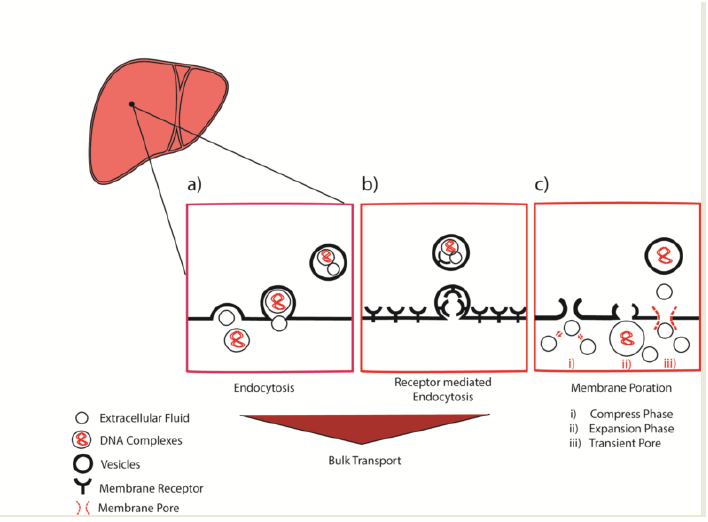
Figure 6. Schematic diagram representing ( a ) Endocytosis ( b ) Receptor mediated endocytosis as the bulk intercellular vesicle transport or ( c ) Membrane poration across the hepatocellular membrane .